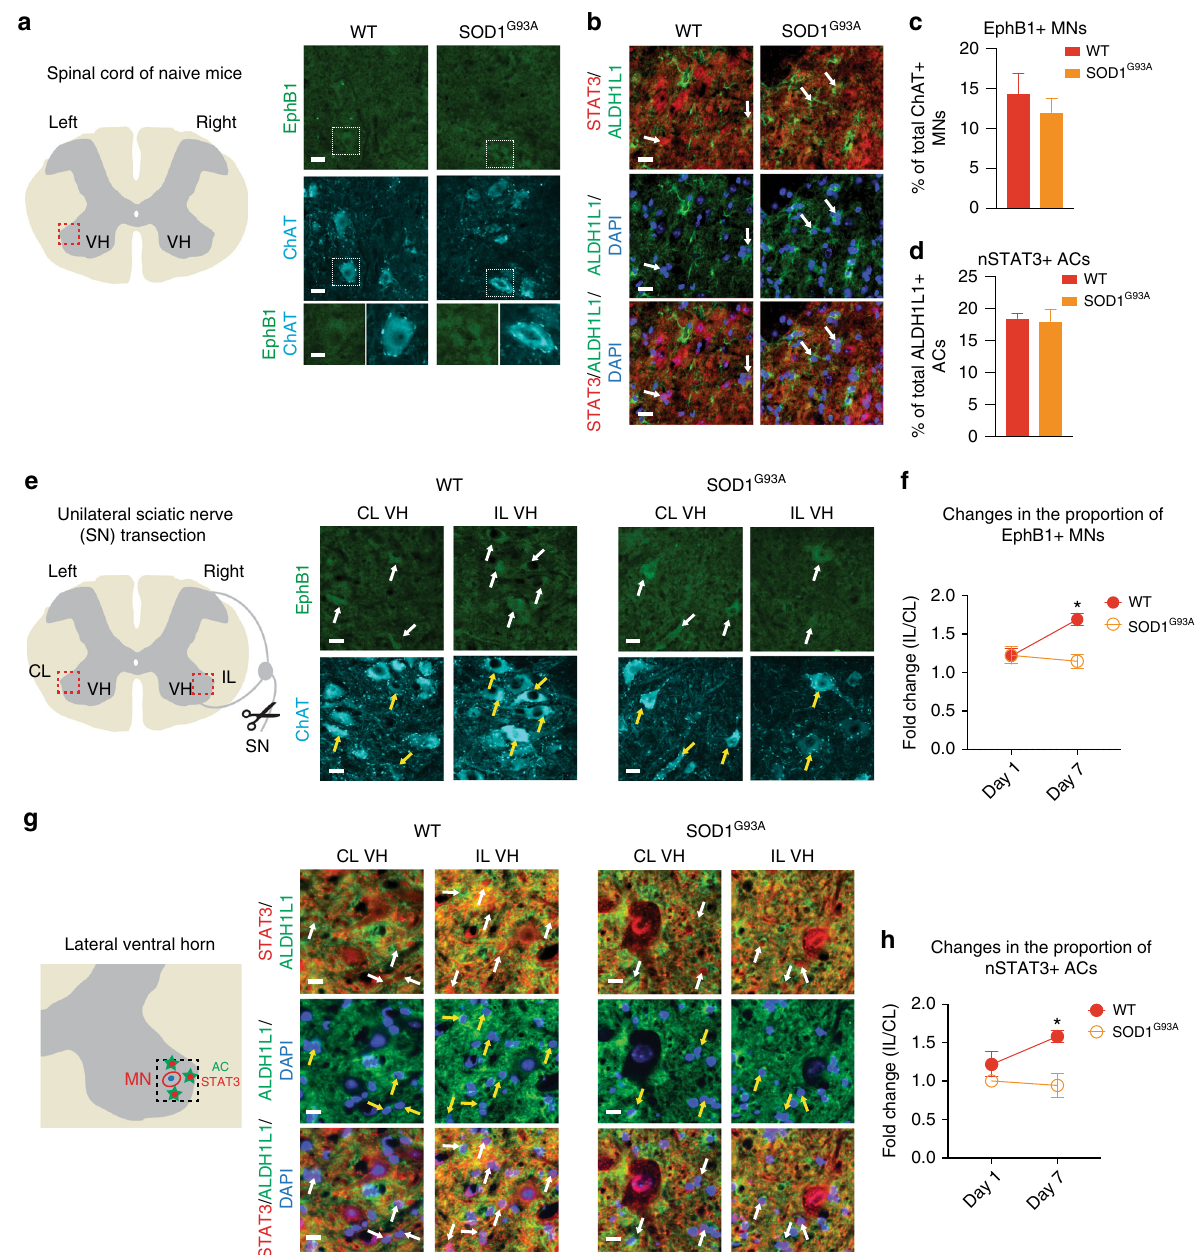
Fig. 5 EphB1 and STAT3 expression patterns in the ventral horn of wild type and SOD1 G93A -ALS mice. a Schematic diagram and immuno fl uorescence images showing very low levels of EphB1 immunolabelling in ChAT-positive motor neurons (MNs) in the ventral horn (VH) of unlesioned wild type (WT) and SOD1-mutant mice. White boxes represent the corresponding cells magni fi ed in the insets for each group. b Immuno fl uoresence demonstrating ALDH1L1-positive astrocytes (ACs) with nuclear STAT3 (nSTAT3) immunostaining (arrows) in unlesioned WT and SOD1-mutant mice. c Graph demonstrates the mean of the EphB1-labelled proportion of ChAT-positive motor neurons in the two groups ( n = 4; p = 0.476, unpaired t -test). d Graph demonstrates the mean of the nSTAT3-labelled proportion of ALDH1L1-positive astrocytes in the two groups ( n = 4; p = 0.821, unpaired t -test). e Schematic diagram and immuno fl uorescence images demonstrating EphB1 positivity (arrows) corresponding with ChAT-labelled motor neurons in the ipsilateral (IL) and contralateral (CL) VH of mice following right-sided sciatic nerve (SN) transection. f Graph shows the mean values of fold changes in the proportion of EphB1-labelled motor neurons in the IL VHs when normalised to the CL side ( n = 4, p = 0.956 for day 1; n = 3, * p = 0.011 for day 7, unpaired t -test). g Schematic diagram and immunostained tissue sections demonstrating ALDH1L1-positive astrocytes with nSTAT3 IR (arrows). h Graph shows mean values of fold changes in the proportion of nSTAT3-positive astrocytes in the IL VHs normalised to the CL side ( n = 3 controls, n = 4 SOD1, p = 0.227 for day 1; n = 4, * p = 0.010 for day 7, unpaired t -test). Data is expressed as mean ± SEM. Scale bar: 40 μ m (20 μ m for